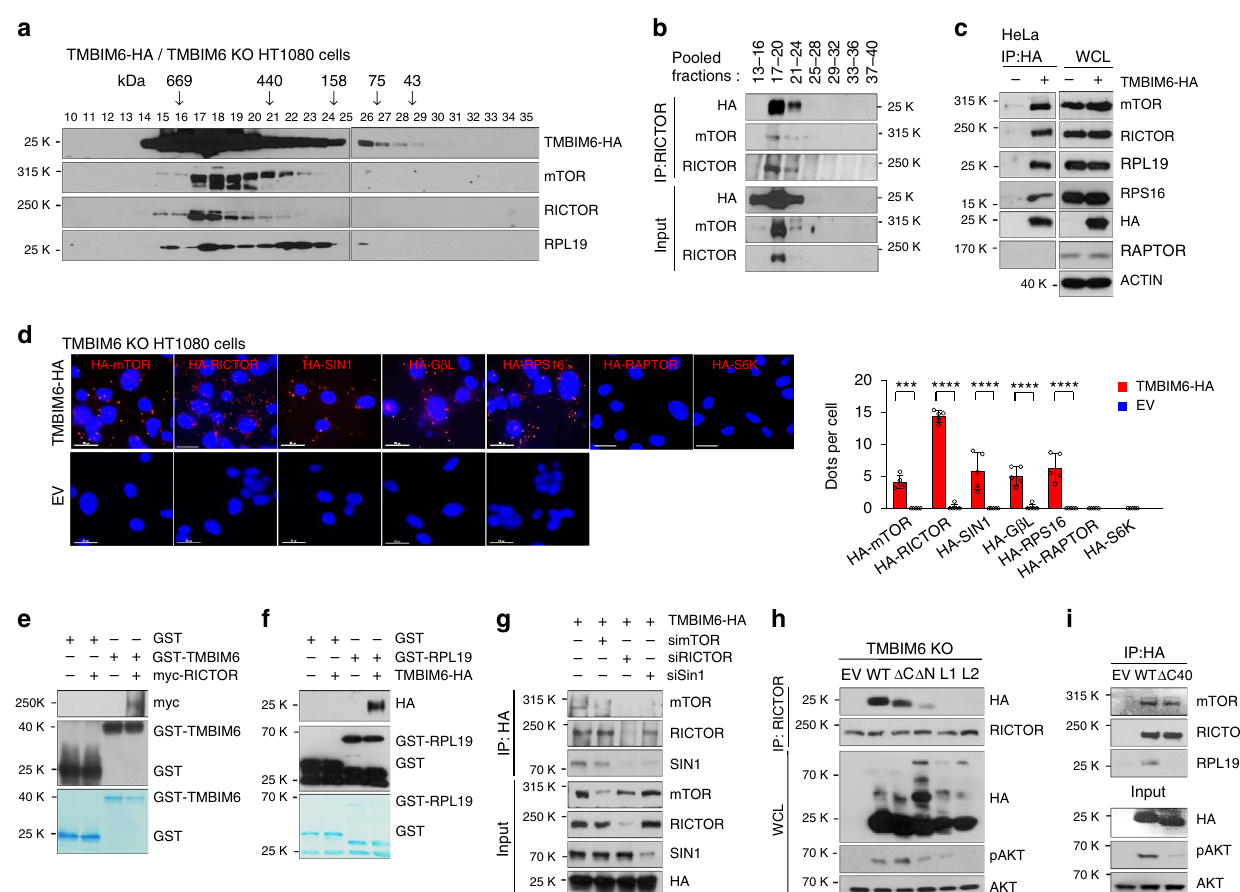
Fig. 5 TMBIM6 directly binds to mTORC2 and ribosomes. a Gel fi ltration assay of lysates of TMBIM6 KO HT1080 cells transiently overexpressing TMBIM6-HA. b Anti-RICTOR immunoprecipitate (IP) of pooled fractions of TMBIM6 KO HT1080 cells transiently overexpressing TMBIM6-HA. The inputs were analyzed by immunoblotting. c Immunoblot analysis of anti-HA IP and whole cell lysate (WCL) of TMBIM6-HA overexpressing HeLa cells. d PLA between TMBIM6-HA and mTORC2 components (red dots) in TMBIM6 stably overexpressing HT1080 cells. Right, quanti fi cation of red dots ( n = 5 independent experiments). Scale bar, 15 μ m. Data are presented as means± SD. *** p < 0.001, **** p < 0.0001, two-way ANOVA followed by Bonferroni ’ s post hoc test. e GST pull-down assay between GST-TMBIM6 and myc-RICTOR. f GST pull-down assay in the presence or absence of HA-TMBIM6. g Immunoblot analysis of WCL of HT1080 cells stably expressing TMBIM6 and transfected with scrambled, mTOR, RICTOR, or SIN1 siRNA and immunoprecipitated with anti-HA antibody. h Immunoblot analysis of the immunoprecipitates with anti-RICTOR antibody and whole cell lysates of HT1080 cells transiently transfected with TMBIM6 and TMBIM6 mutant constructs. i Immunoblot analysis of the immunoprecipitates with anti-HA antibody